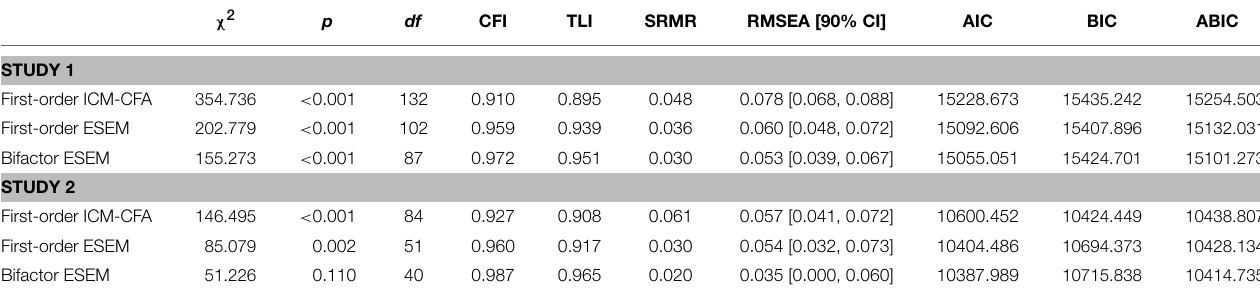
TABLE 2 | Model Fit of the ICM-CFA and ESEM Models.